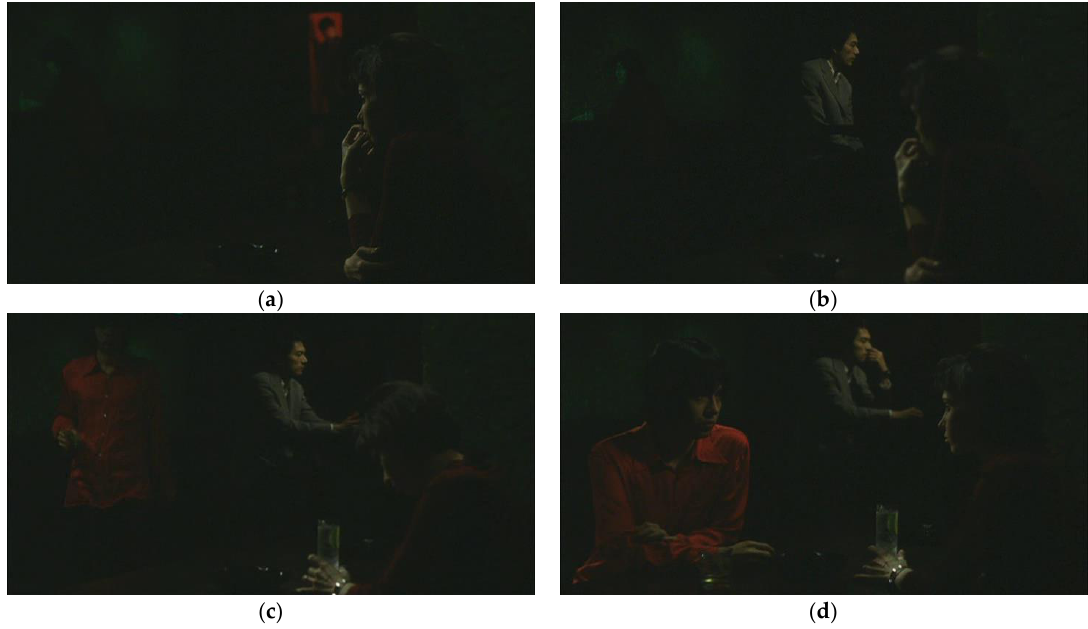
Figure 3. Four frames from H Story taken of a unique static shot showing the entrance of actors Hiroaki Umano ( a,b ) and Kou Machida ( c,d ) changing the dynamic of attractions around the main character played by Béatrice Dalle (at the right of the images). Source: DVD edition by Cinéma Indépendant (France).